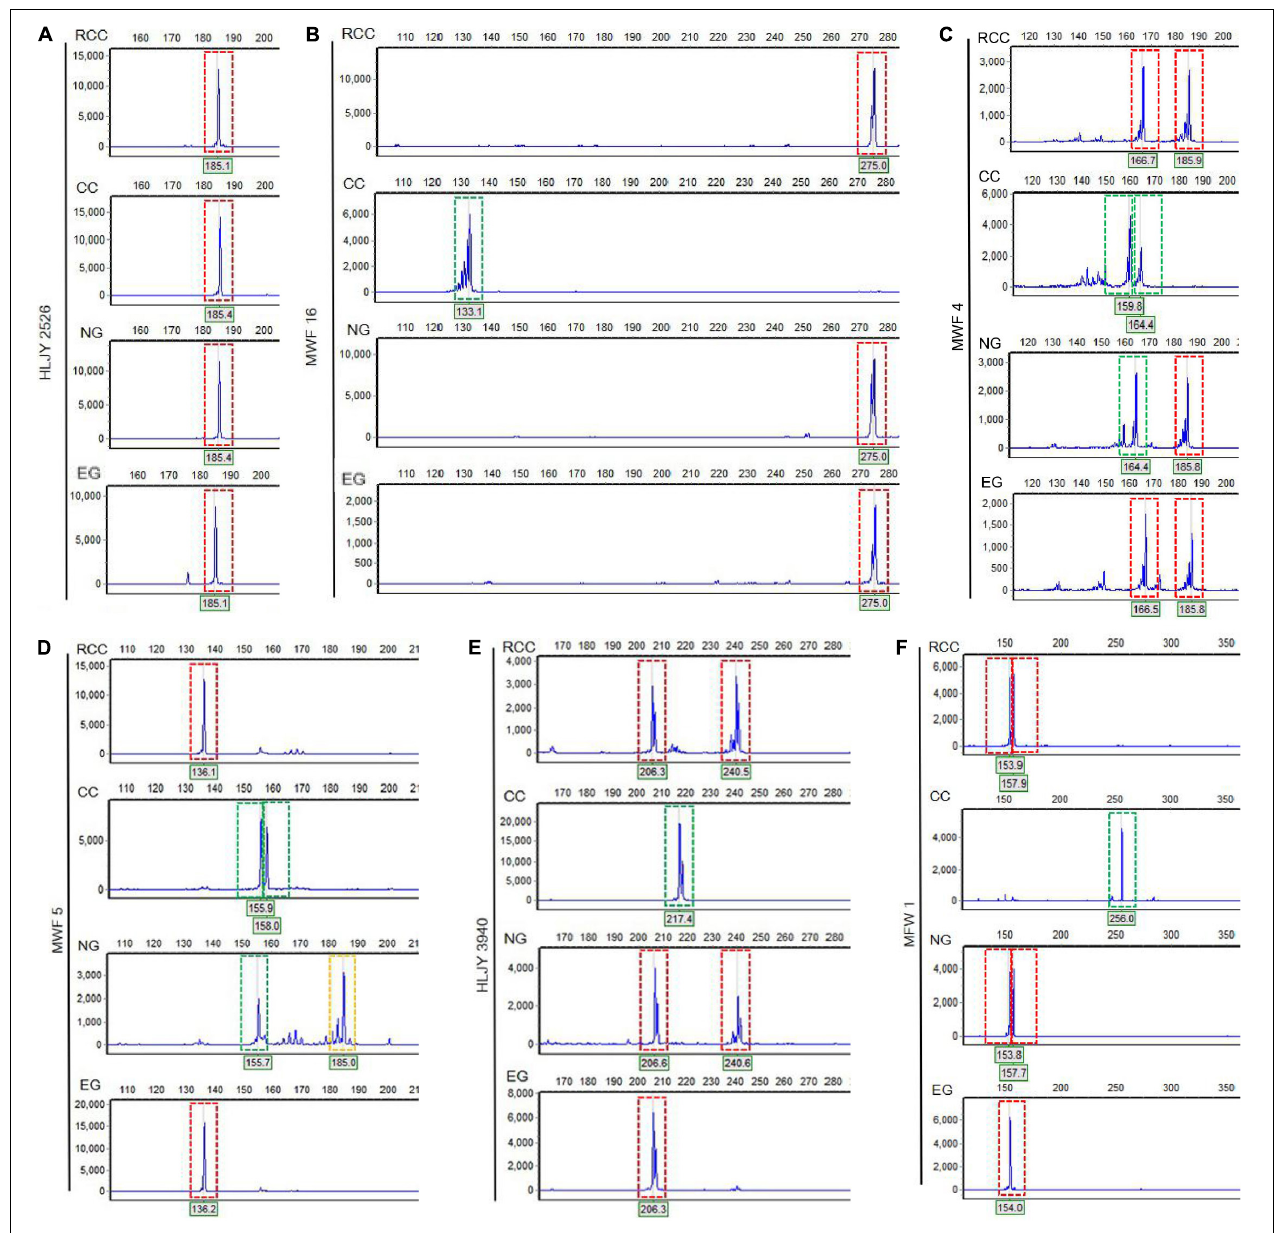
FIGURE 3 | Electropherograms showing allelic peaks at six loci across the four fish lines. (A) HLJY 2526 locus. (B) MWF 16 locus. (C) MWF 4 locus. (D) MWF 5 locus. (E) HLJY 3940 locus. (F) MFW 1 locus. Peaks boxed in red are unique to the crucian carp; peaks boxed in green are unique to the common carp; peaks boxed in yellow are unique to the natural goldfish. The x -axes show the size of each segment, and the y -axes indicate the strength of the corresponding signal.